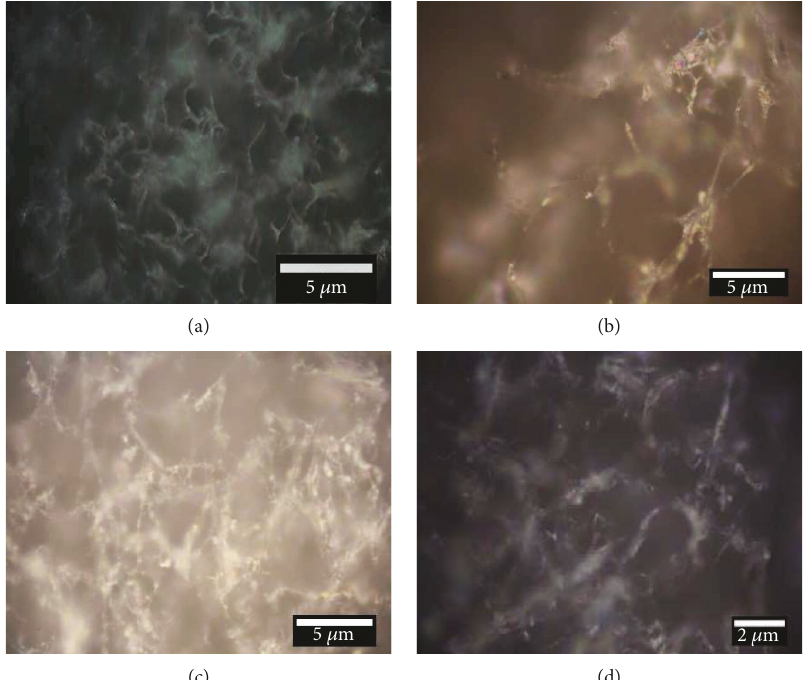
Figure 3: Optical microscopy images for collagen sponge (a) (100x), 1% piroxicam collagen (b) (50x), 1.5% piroxicam collagen (c) (50x), and 2% piroxicam collagen (d)